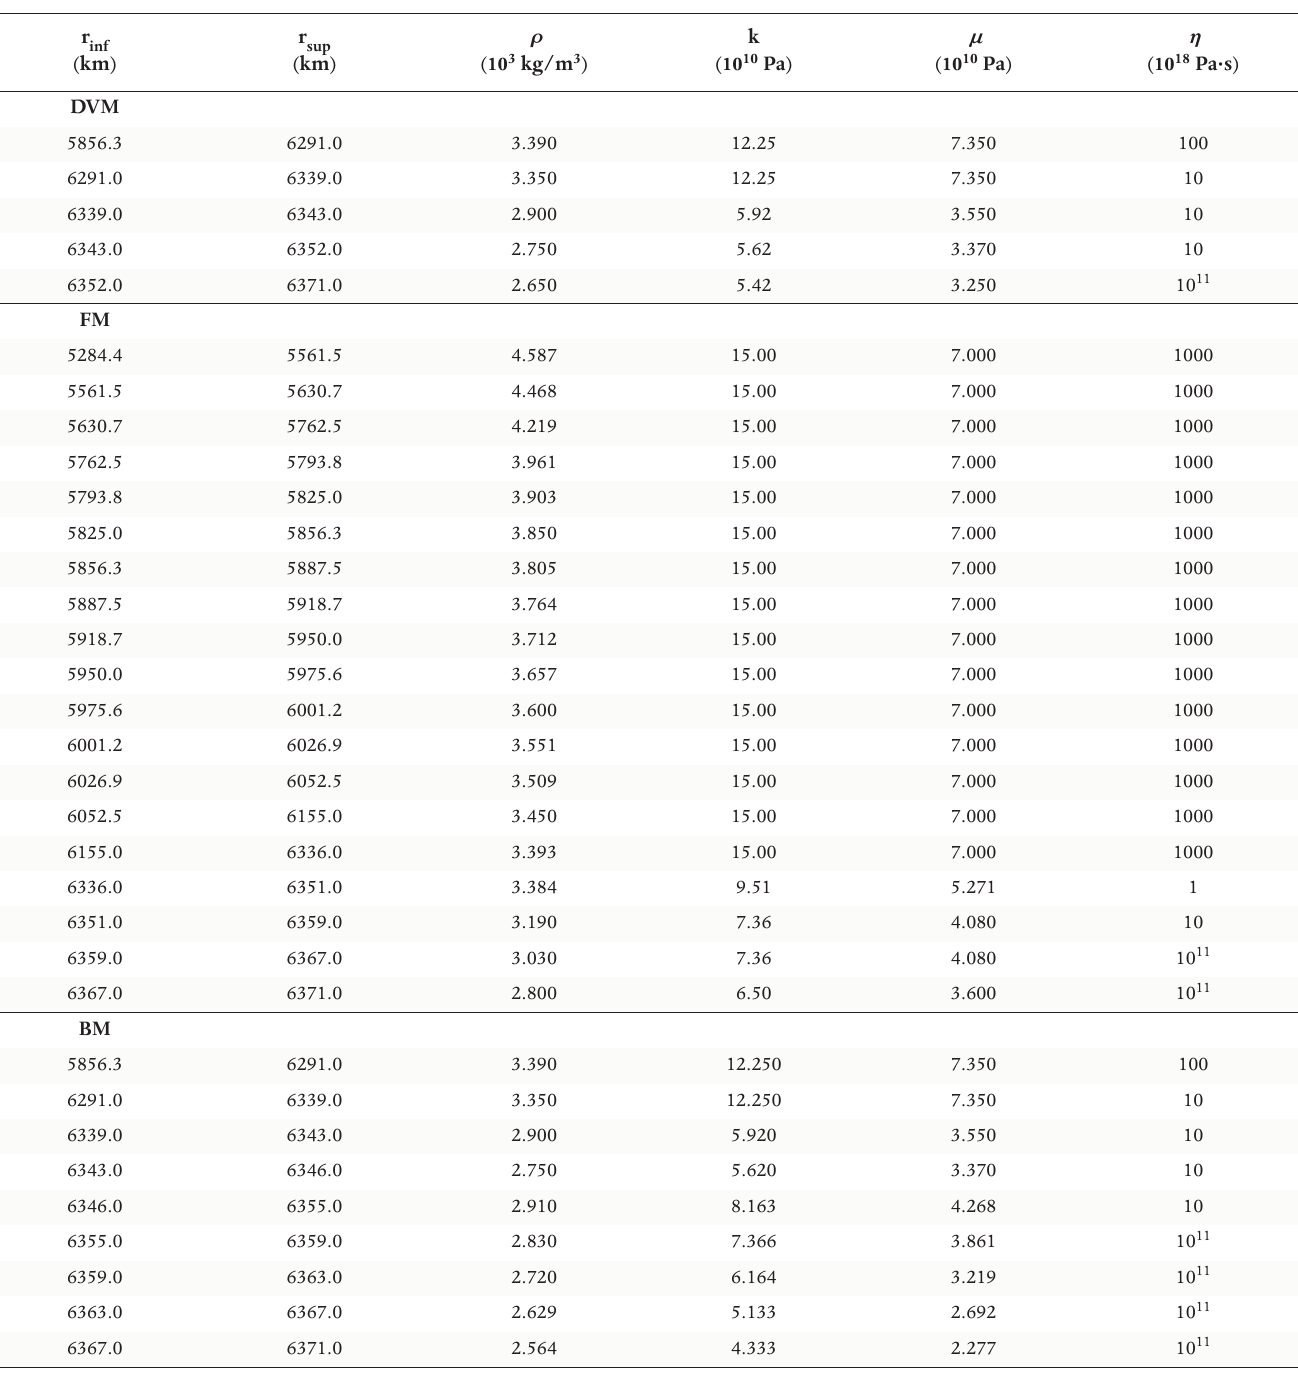
Table 3. Earth models: DVM , modifed from Dalla Via et al. [2003, 2005]; FM , modifed from Amoruso et al. [2005b]; BM , modified from Bagh et al. [2007]. r , bottom radius of each layer; r , top radius of each layer; t , density; k, bulk modulus; n , shear modulus, h , inf sup